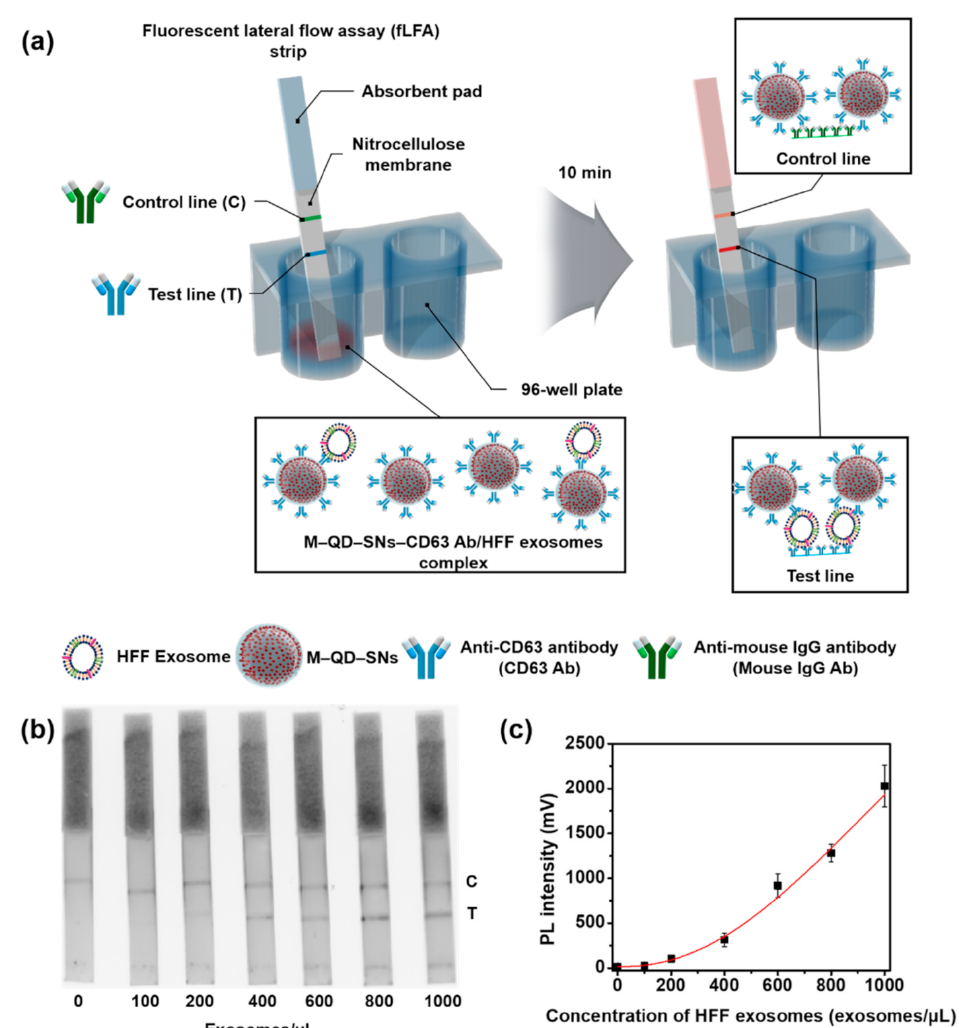
Figure 3. Detection of HFF exosomes using M–QD–SNs in the fLFA. ( a ) Schematic illustration of the configuration and measurement principle of the M–QD–SNs and exosome detection system. ( b ) Qual- itative analysis of HFF exosomes by concentration (0, 100, 200, 400, 600, 800, and 1000 exosomes/ µ L) under LAS-4000. ( c ) Correlation analysis of the detectable concentration by a lateral flow immunoas- say (PL intensity) and HFF exosome concentrations from 100 to 1000 exosomes/ µ L. Error bars denote the standard deviations of three independent